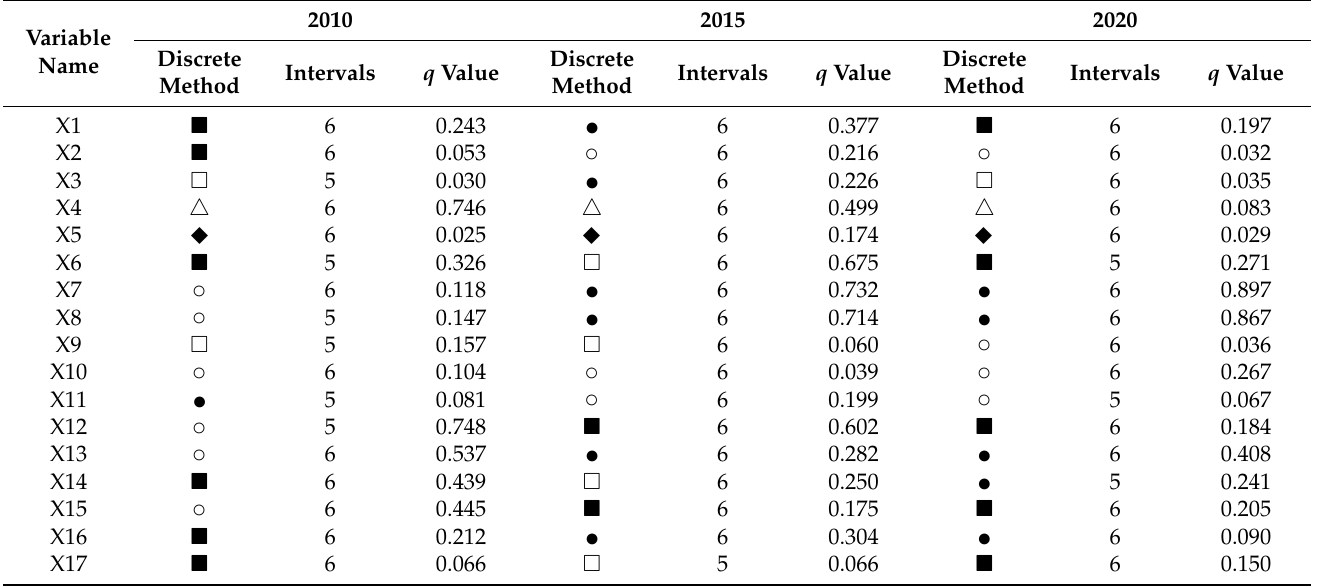
Table 7. Spatial discretization methods and factor detection results for each indicator.